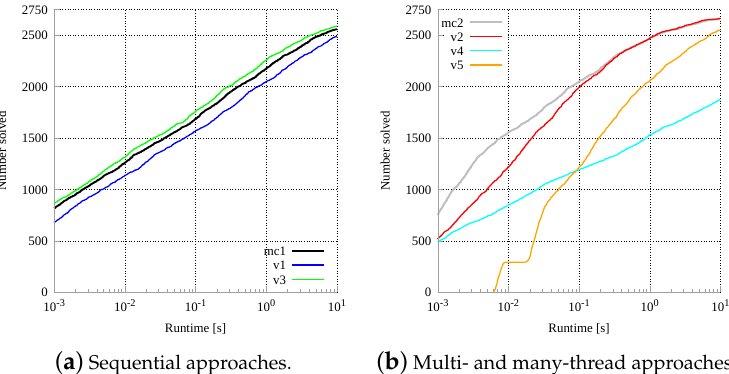
Figure 7. Cumulative number of instances (y-axis) solved under a certain time (x-axis) plotted separately for the sequential and parallel